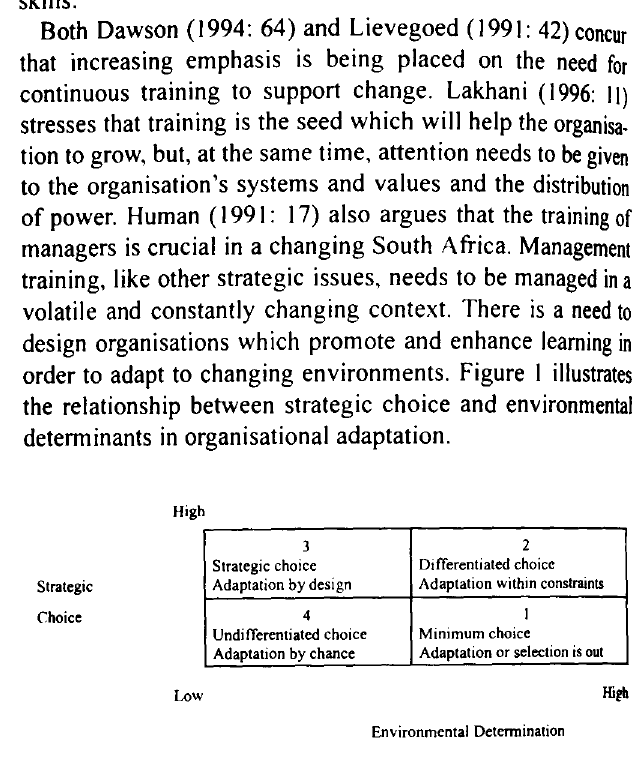
Figure 1 Relationship between strategic choice and environmental determinants in organisational adaptation (Source: Jones & Mann, 1992: